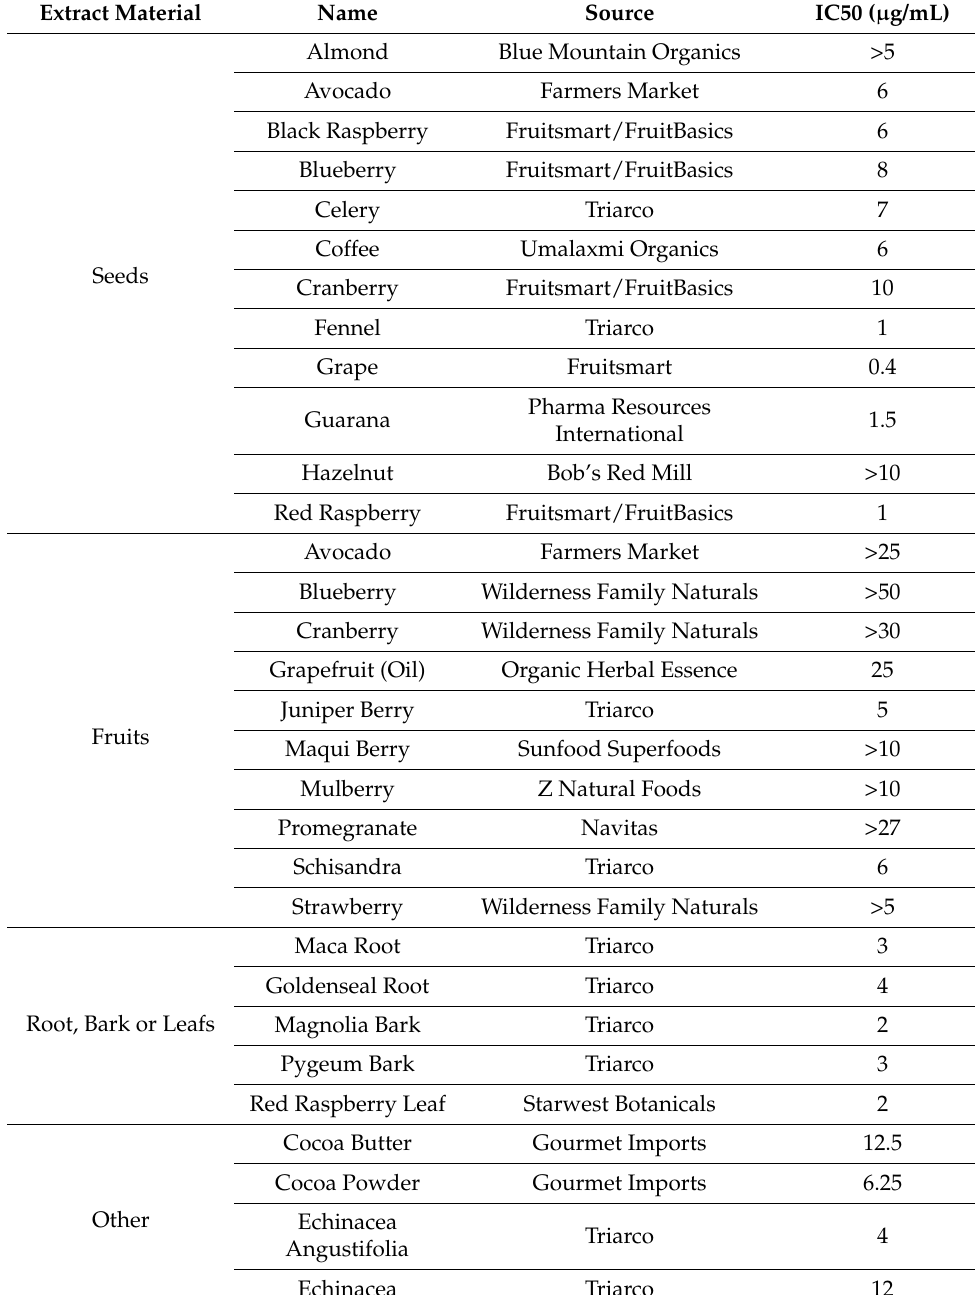
Table 1. Summary results of Botanical extracts in PP2A demethylation activity